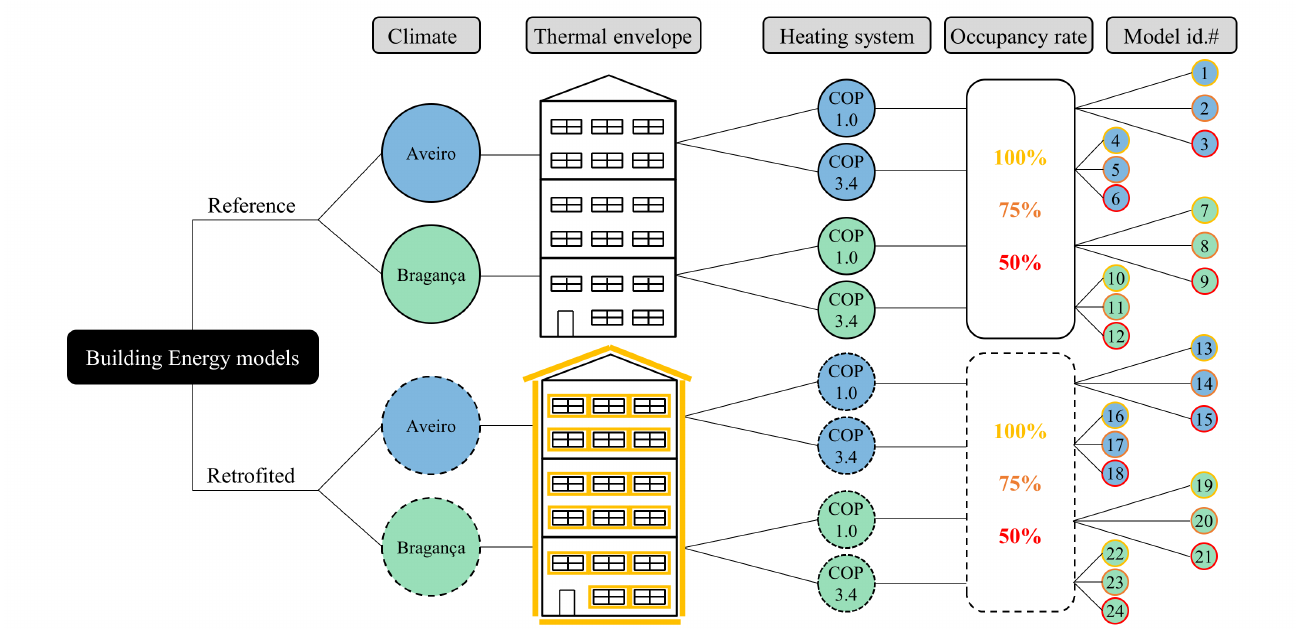
Figure 7. Layout of the building energy